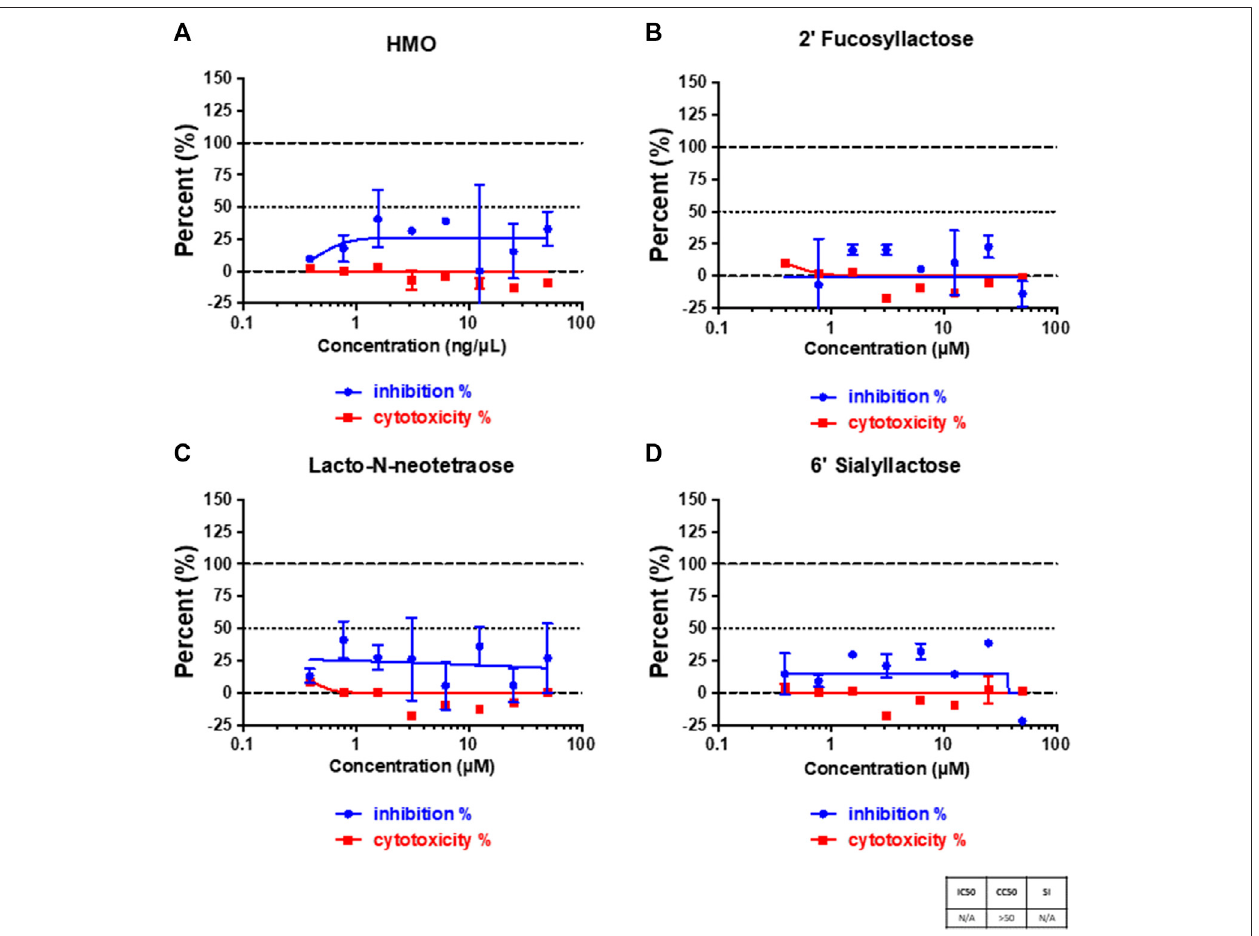
FIGURE1| Viralinfectiononcellsandcytotoxicityassays.Cellplateswerepre-treatedwithpooledHMOs (A) ,2 ′ -FL (B) ,LNnT (C) ,and6 ′ -SL (D) ,respectively.The treatment was performed for 2 h at 37 ° C (5% CO 2 ) prior to infection. The percent of infected cells was determined for each well based on GFP expression. All samples were run in triplicate on both an assay plate and a toxicity